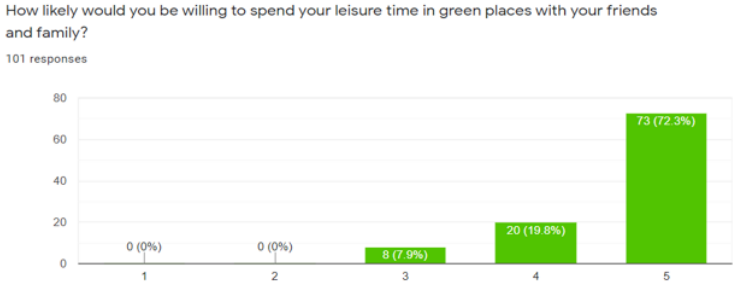
Uses of Recreational Area to Assess the Feasibility of Proposed System Ninety one out of 105 people says that they will use this place to relax, 77% of people would like to use these places for recreation (Hautamäki & Donner, 2021). This is confirmed by Figure 7 which states that 7.9% of respondents are neutral when asked to check whether they would be willing to spend leisure time in green places; 19.8% agree whereas 72.3% strongly agree to spend leisure time in green places with friends and family. This sums up to 91% (Sun et al., 2019), 84% of people want to have such a fishing place, and 91% of people prefer water sports/boating area in Karachi.